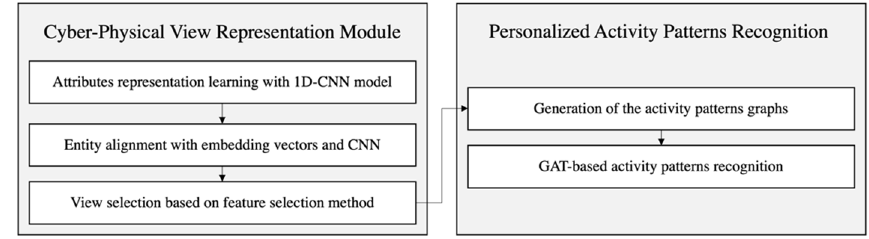
Figure 2. Overall structure of the KARE framework.